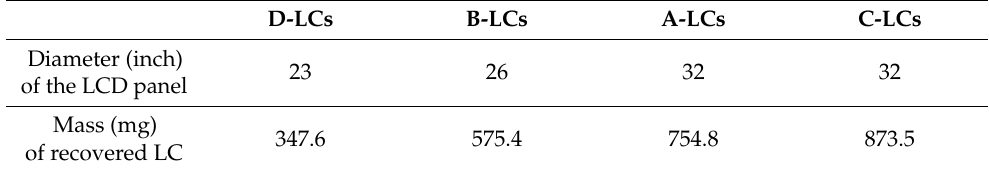
Figure 4. Weight of LCs mixtures extracted manually from 31 EOL-LCD panels. Table 1. Amount of LCs mixtures extracted from selected EOL-LCD panels A, B, C and D.